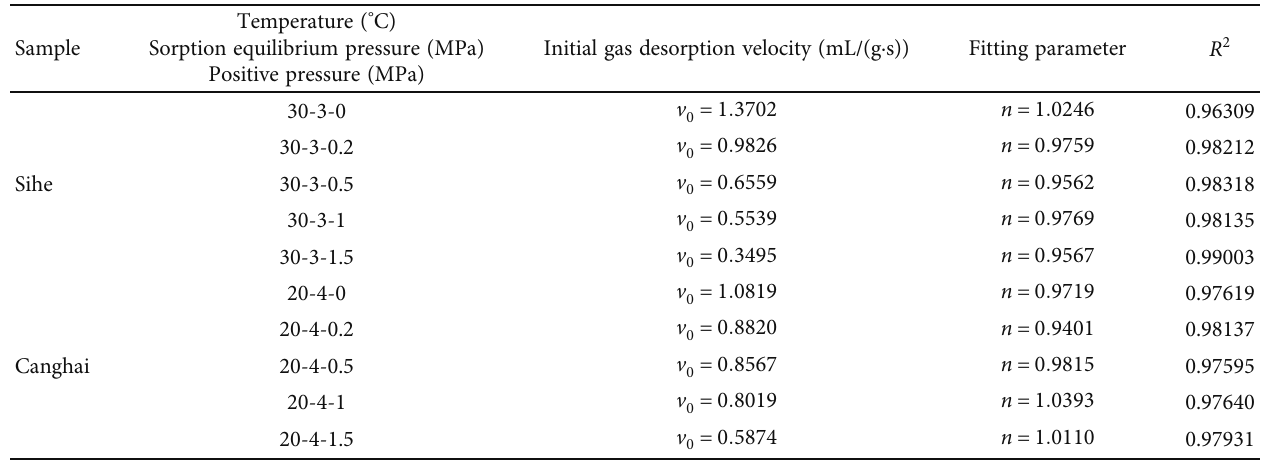
Table 3: Parameters of gas desorption